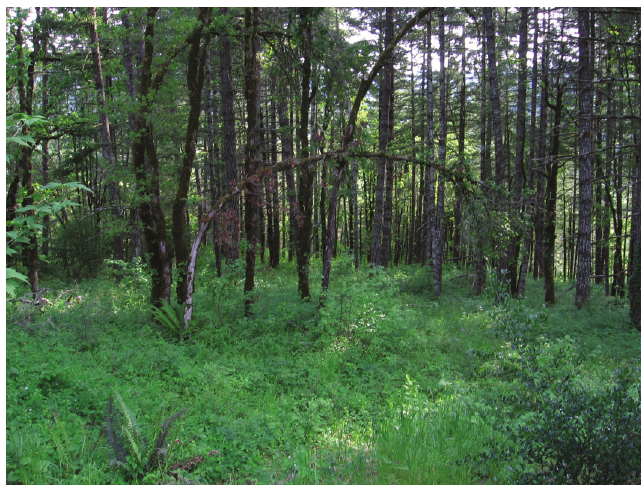
Figure 5. Second-growth mixed forest near Dallas, Oregon.